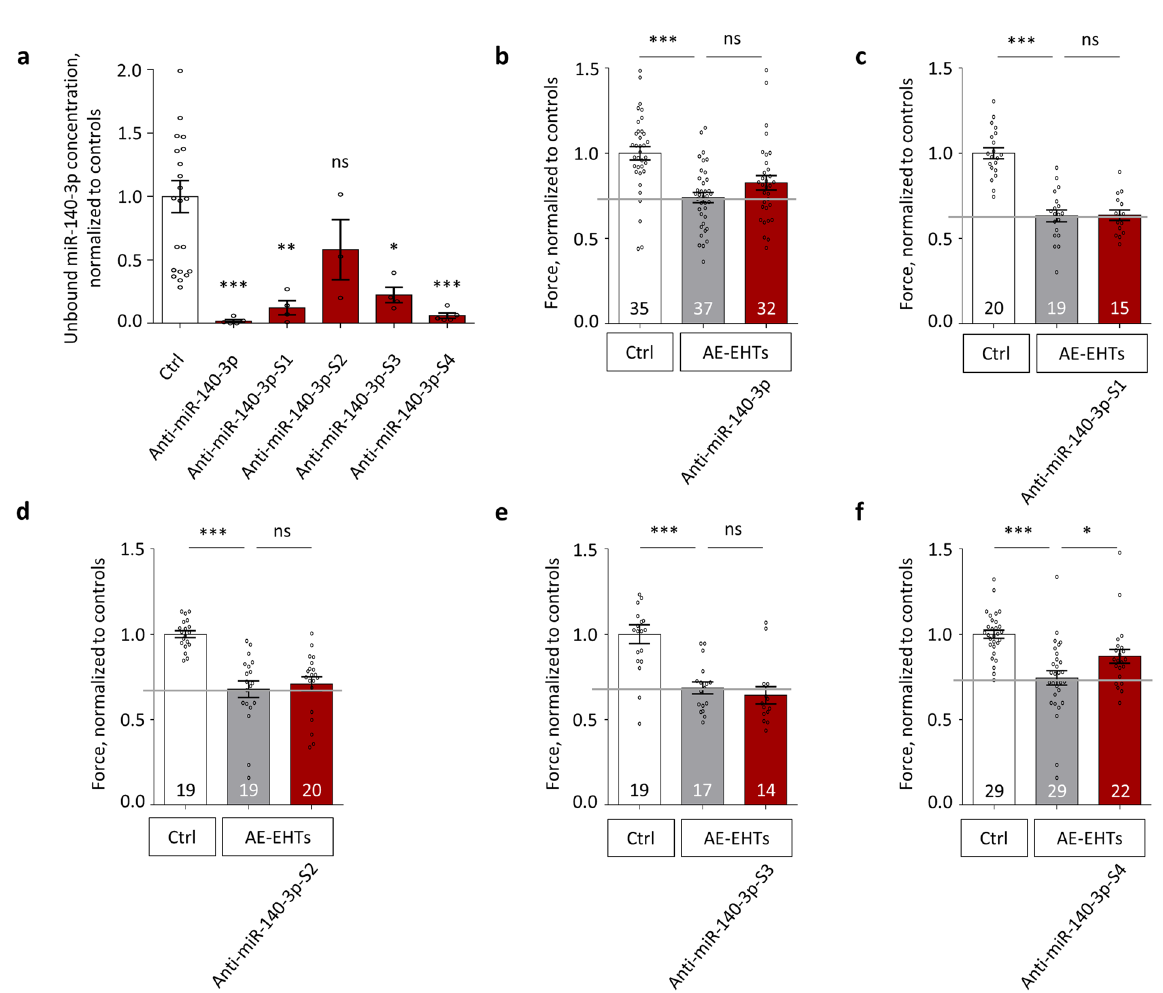
Figure 4. Evaluation of shorter anti-miRs targeting miR-140-3p. ( a ) Concentrations of free miR-140-3p (i.e., not bound to an LNA-anti-miR) at the end of the experiments, n = 3–22 EHTs per group. ( b – e ) Contractile force of Ctrl-EHTs, AE-EHTs and AE-EHTs pretreated with a long anti-miR-140-3p and four shorter anti-miR- 140-3p (S1–S4). Bars show mean ± SEM, one-way ANOVA and Dunnett’s post-test for multiple comparisons against Ctrl, * p < 0.05, ** p < 0.01, *** p < 0.001, all numbers refer to total number of EHTs per group.